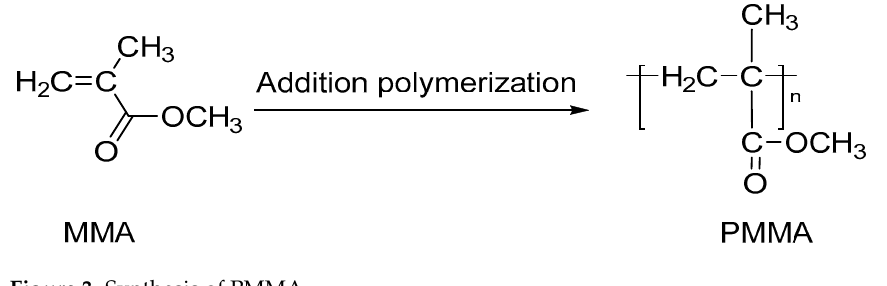
Figure 3. Synthesis of PMMA.